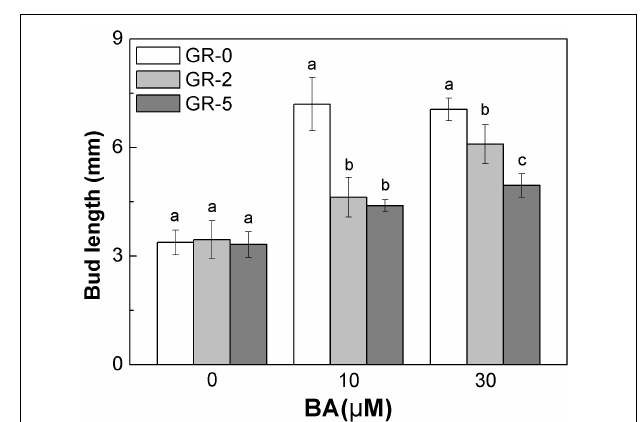
FIGURE 7 | Strigolactone reduces the stimulatory effect of BA-induced bud outgrowth in rice. rac-GR24 and/or BA were supplied to the axillary bud directly on node 2 at the full heading stage. Bud length of 60 buds at node 2 was measured 3 days after treatment. Vertical bars in C represent mean ± standard error values ( n =